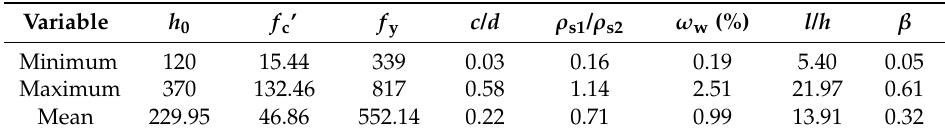
Table 6. Range of parameters in the